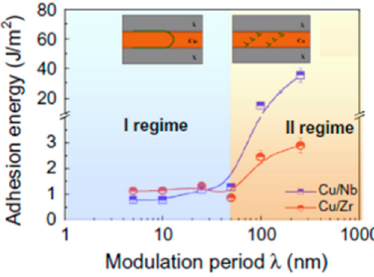
Figure 18. Length scale dependent deformation behavior on the evaluated adhesion energy in NMMFs. Two regimes divided by λ crit represent the λ -independent and λ -dependent ranges, respectively [52].